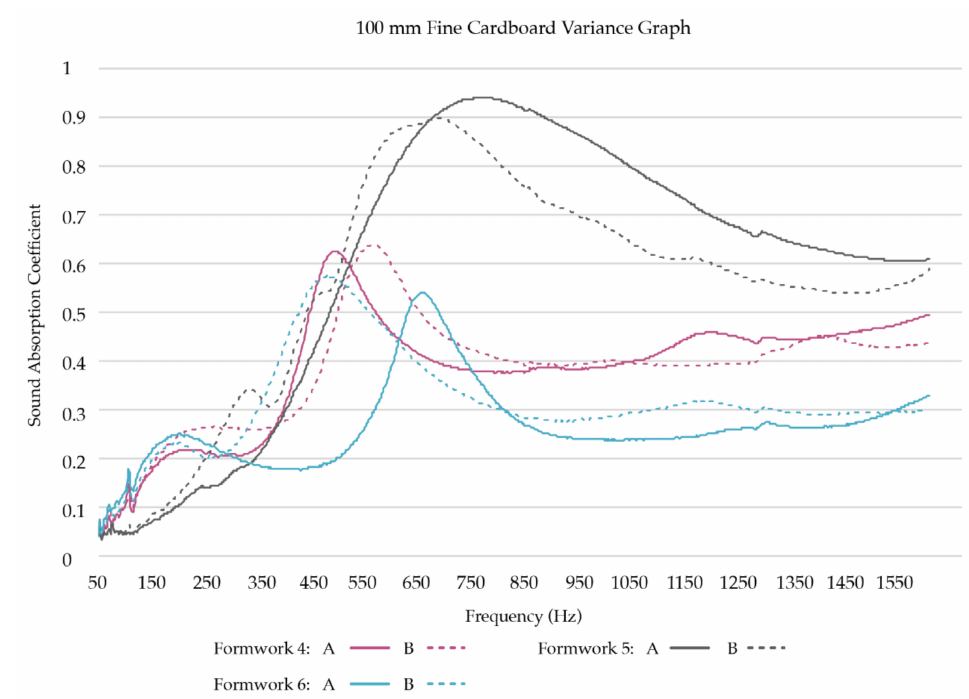
Figure 9. Sound Absorption Coefficients of SCL replicates (100 mm).